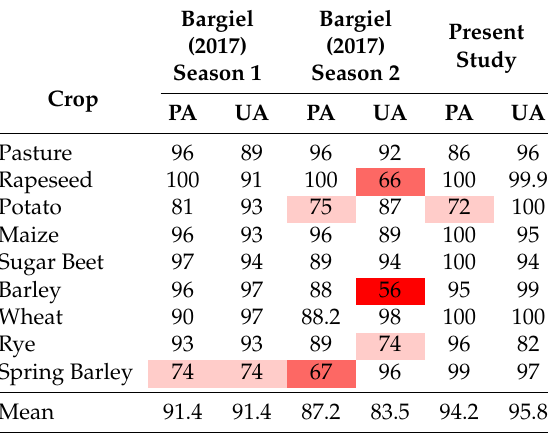
Table 7. Comparison of the Producer’s Accuracy (PA) and User’s Accuracy (UA) (in %) of crop classes of the study carried out by [22] and of the present study. Unsatisfactory results below 80% are marked in red ( 80%–70% , 70%–60% , below 60% ). The classes Oat, Pea, and Carrot, appeared merely in one of the classifications and were left